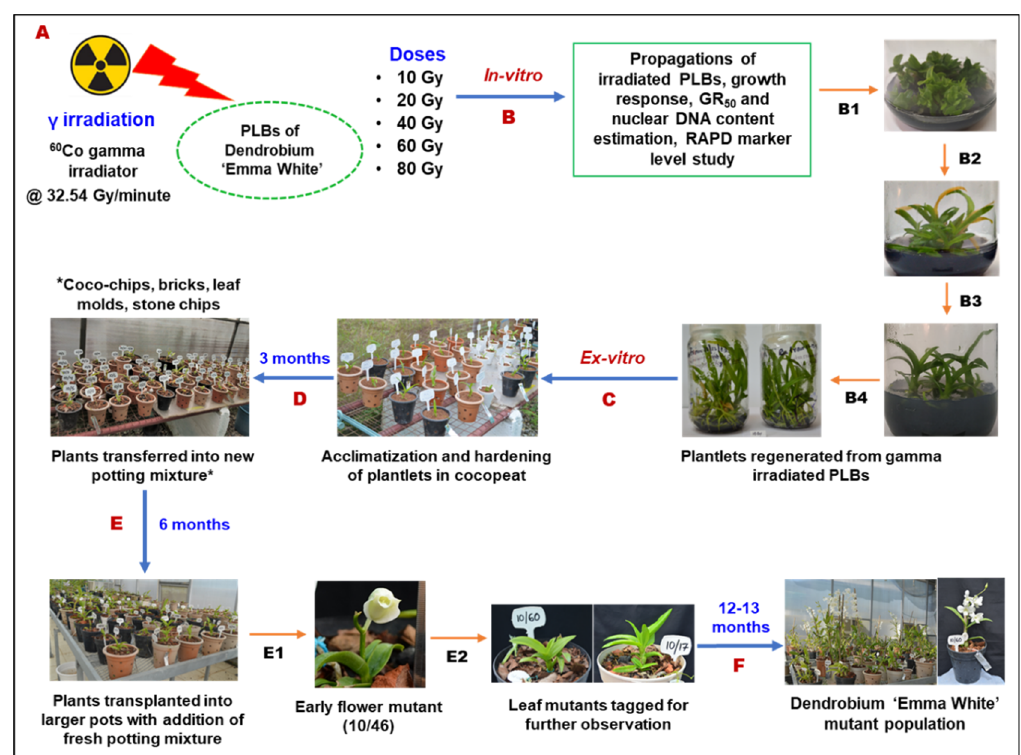
Figure 10. Workflow of gamma irradiation-induced mutagenesis in Dendrobium ‘Emma White’. ( A ) Protocorm-like bodies (PLBs) generated from the shoot-tip of ‘Emma White’ was irradiated with different doses of gamma rays (10, 20, 40, 60, 80 Gy); ( B ) Irradiated PLBs were transferred onto the fresh culture medium and incubated in a culture room at 22 ± 2 ◦ C and 65–70% relative humidity with 16 h of photoperiod. After three and six months of gamma irradiation, growth response of PLBs was recorded based on proliferation and regeneration percentage; nuclei isolated from PLBs irradiated with gamma rays were used for estimation of nuclear DNA content based on fluorescence intensity using high throughput cell analyser (HTCA); genetic diversity of in-vitro plantlets regenerated from gamma irradiated PLBs at dose 10, 20, and 40 Gy were analysed using random amplified polymorphic DNA (RAPD) markers; ( C ) Ex-vitro acclimatization and hardening of well rooted mutant and control plantlets in coco-peat; ( D ) After three months, plants were re-potted into a mixture of media containing coco-chips, brick pieces, leaf molds, and stone chips in 1:2:2:1 ratio; ( E ) After six months, plants were transplanted into larger pots with fresh potting mixture; ( E1 ) First flowering in mutant 10/46 was observed within 294 days of ex-vitro growth; ( E2 ) Morphological variations were observed in leaves of 10 Gy mutant plants as compared to control; ( F ) After twelve to thirteen months, well-grown Dendrobium ‘Emma White’ mutant population were established with early flowering at dose 10